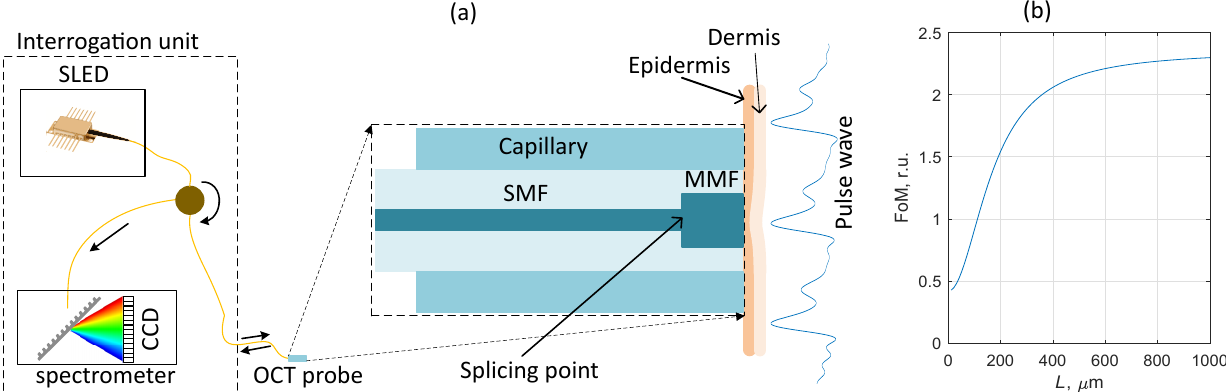
Figure 3. Schematic illustration of the proposed OCT pulse wave sensing system ( a ) and dependence of figure of merit on the imaging depth ( b